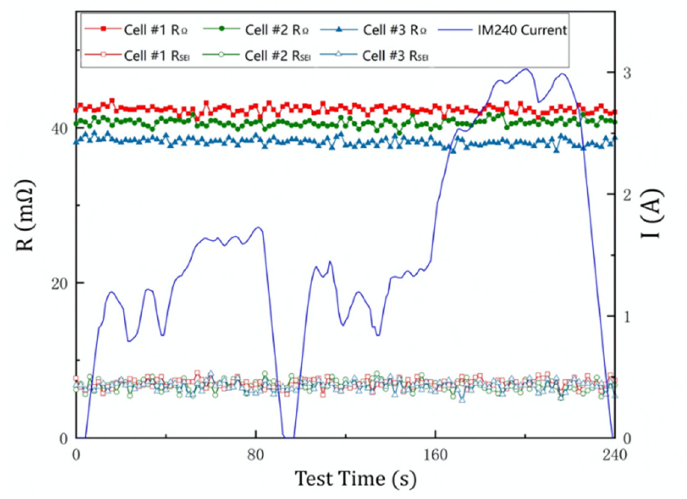
Figure 8. R Ω and R SEI data of three sample batteries during IM240 test. The data are measured by dynamic fast DCIS.